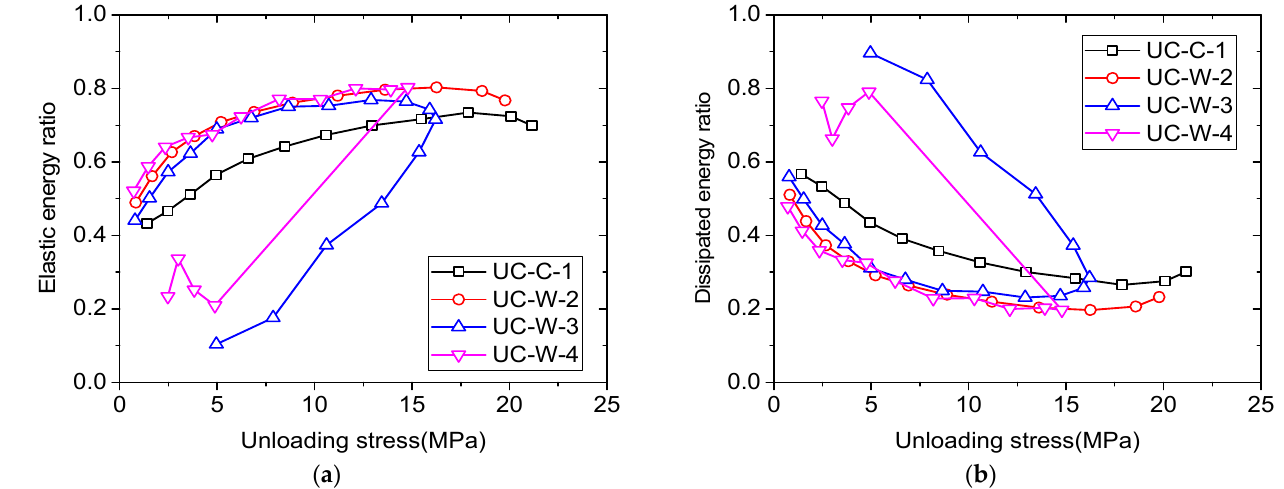
Figure 16. ( a ) Relationship between elastic energy ratio and unloading stress, and ( b ) the relationship between dissipated energy ratio and unloading stress.